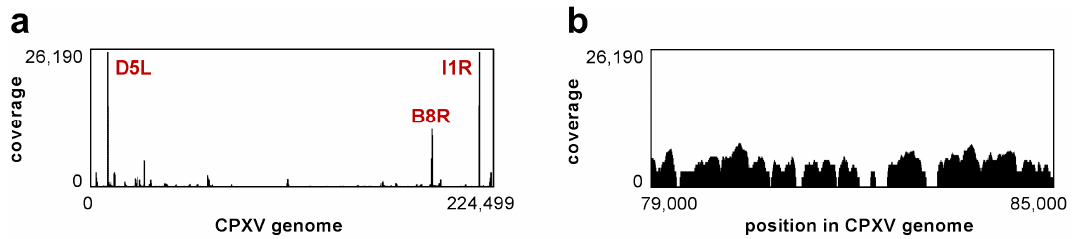
Figure 2. Exemplary coverage across the CPXV genome. Transcripts were analyzed in highly pure CPXV IMV particles using NGS. ( a ) Multiple genes show exceptionally high coverage (red: gene names according to CPXV GRI-90), while some regions displayed no mapping reads at all ( b ). The coverage is shown exemplarily for HEp-2-passaged virions protocol I, but coverage distributions were similar in all samples.